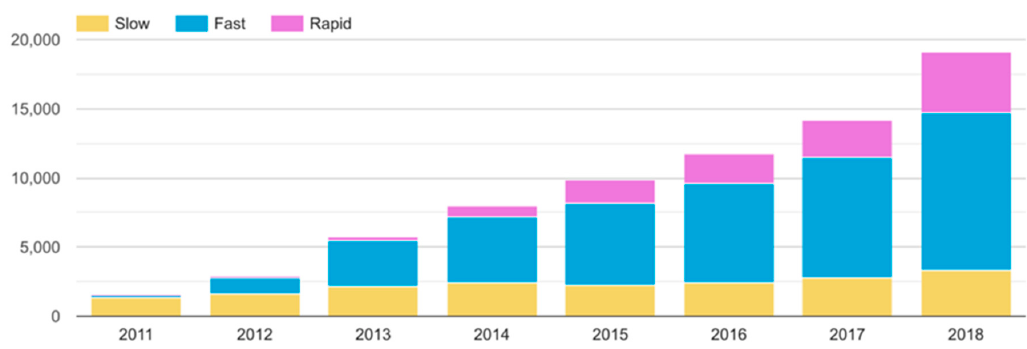
Figure 3. Total number of charging connectors in the UK. Reproduced from [54].